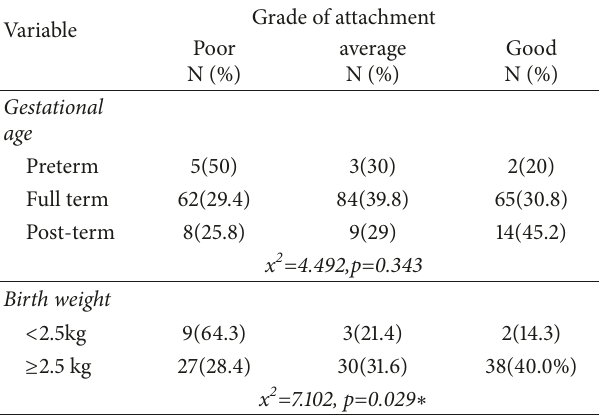
Table 3: Cross-tabulation of Attachment (latch-on) and infant characteristics at Areka town, Southern Ethiopia,